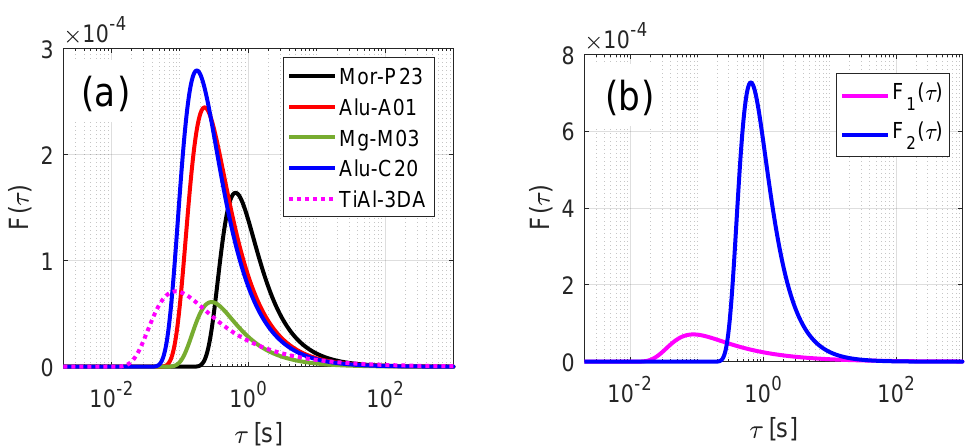
Figure 7. Best fitting distributions F ( τ ) for different samples. ( a ) One peak distributions. The first distribution for the titanium alloy is also reported for reference. ( b ) Two peaks distribution. The two distributions are reported separately and F ( τ ) = F 1 ( τ ) + F 2 ( τ )